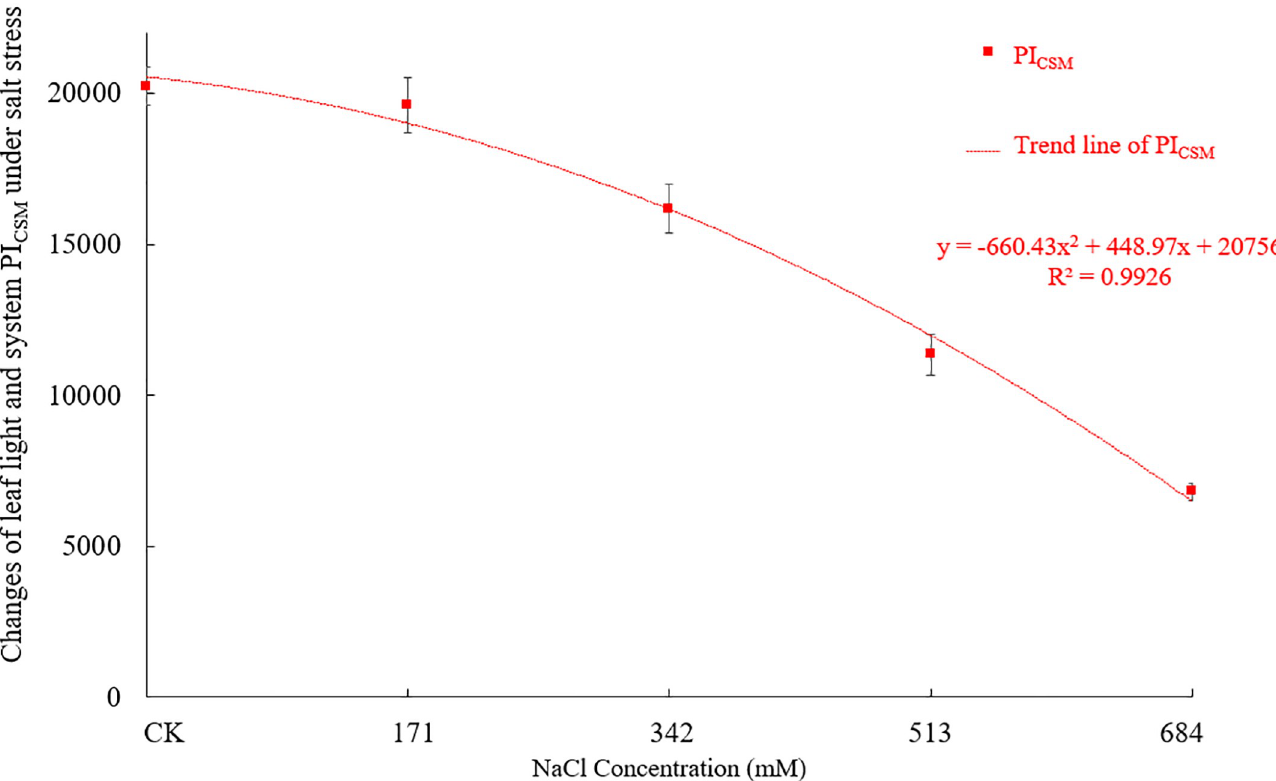
Fig 13. The changes of performance index and driving force (PI CSm ) under different salt stress.